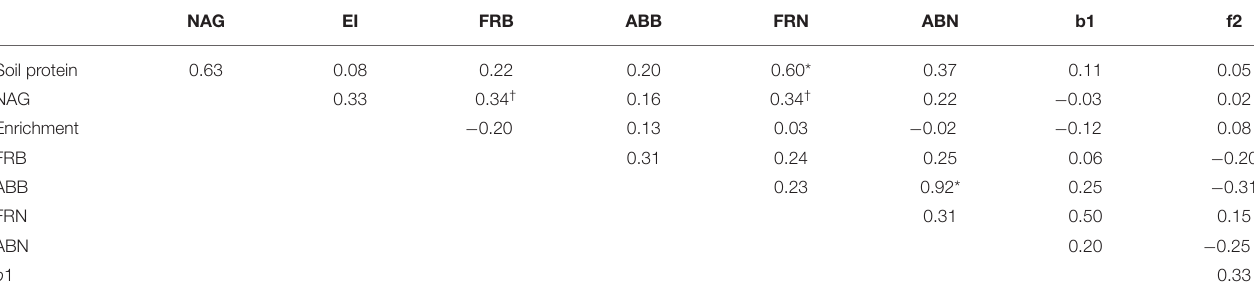
TABLE 4 | Pearson’s correlation coefficients ( r ) between plant and soil nitrogen pool indicators at harvest 2020.